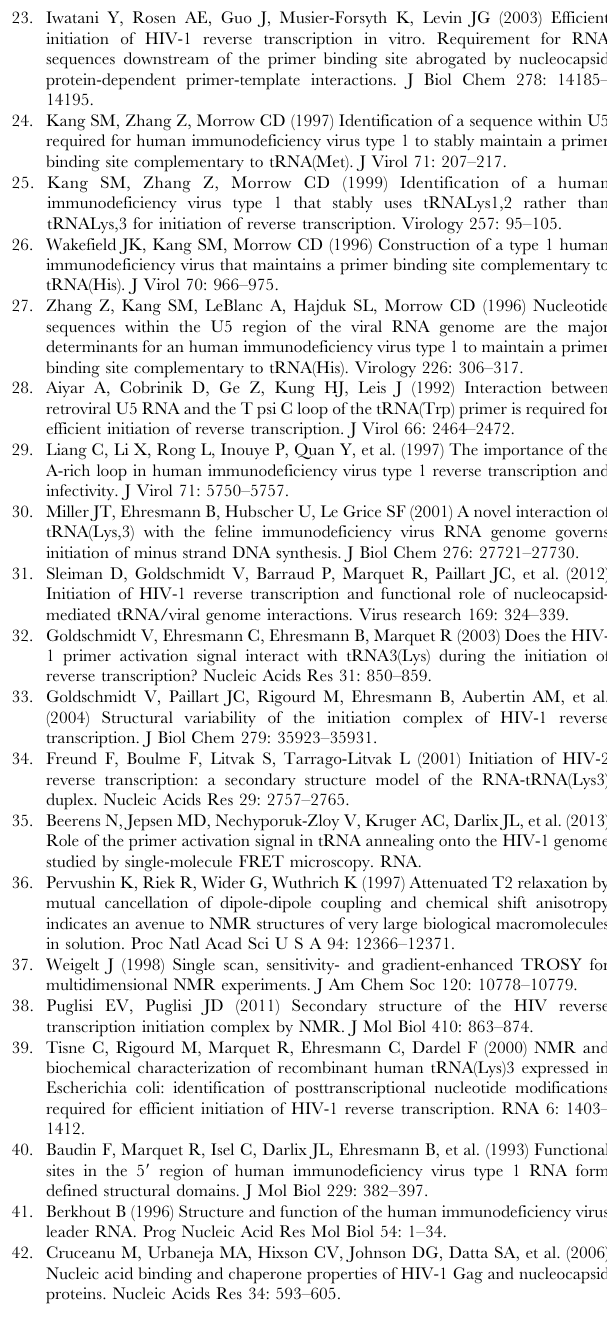
Figure S6 Region of the imino protons of the 1 H NMR spectra of the PAS ds alone (0.16 mM) and of the PAS ds (0.16 mM) mixed with NCp7 at 1:1 ratio. The spectra were recorded at 15 u C using a watergate sequence to [58] to achieve water signal suppression.